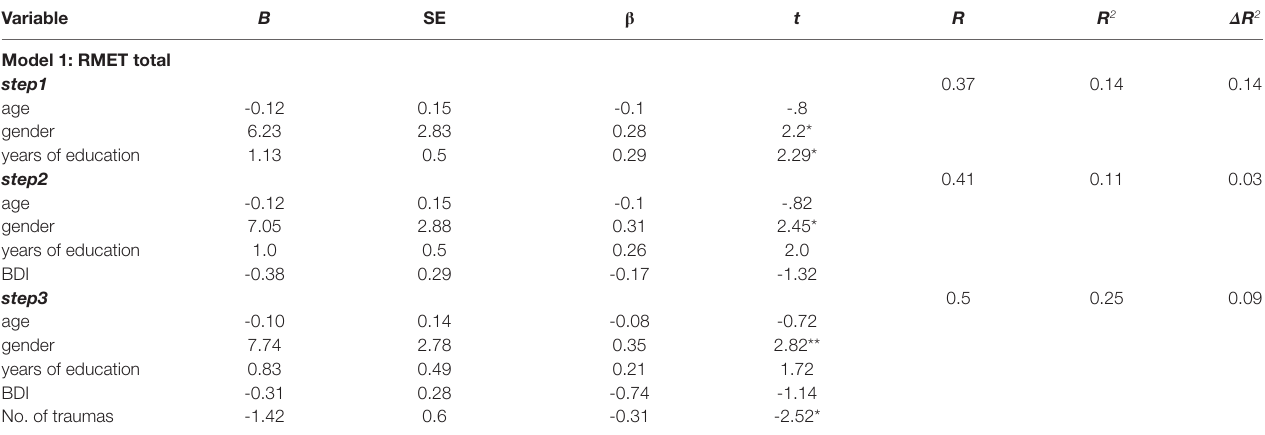
TABle 5 | Summary of hierarchical regression analysis for variables predicting RMET total score. Variable B se Model 1: RMeT total